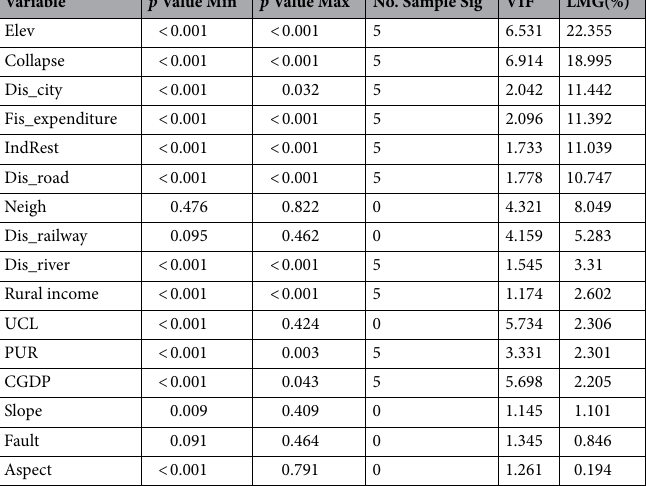
Table 4. Significance of independent variables of 5 intermediate models and the importance of variables based on LMG (%) in MLR. “No. sample sig.” represents the number of samples where each variable is